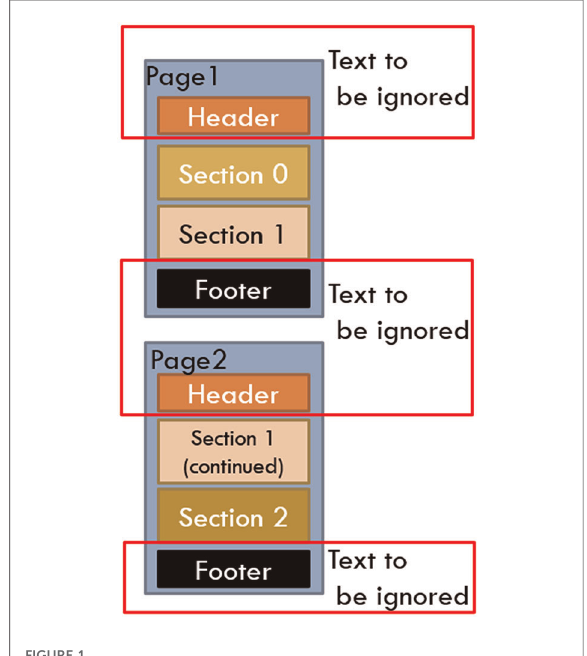
FIGURE 1 OCR and format challenges: page headers and